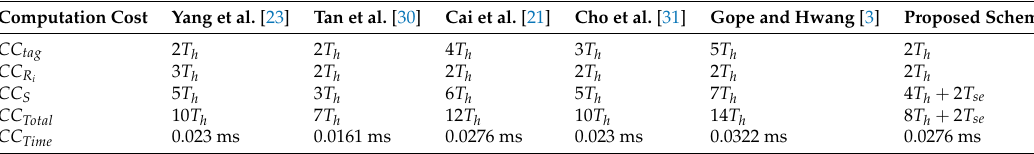
Table 5. Comparison of computation cost and running time.